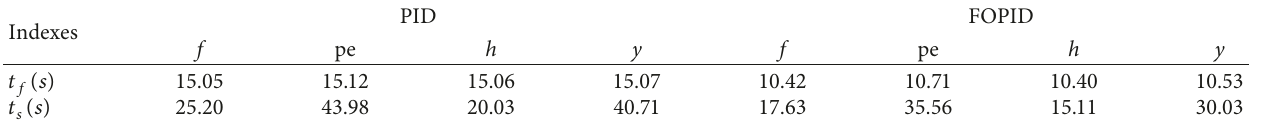
Table 11: Comparison of performance indexes with Δ f � − 0 . 5